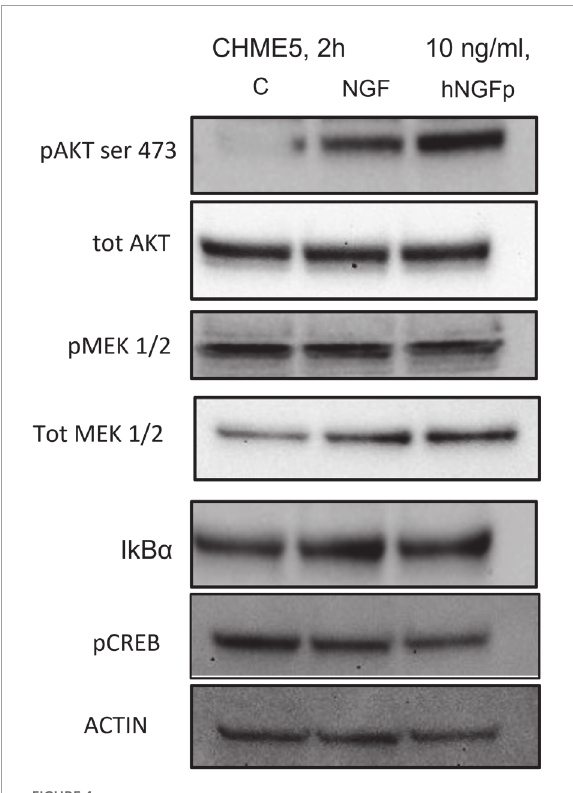
FIGURE4 Evaluation of tropomyosin receptor kinase A (TrkA) and p75NTR pathway in CHME-5 cells treated for 2 h with nerve growth factor (NGF) isoforms. Treatments: lanes 1, control; lane 2, 10 ng/ml NGF; lane 3, 10 ng/ml painless human Nerve Growth Factor (hNGFp). The following proteins were evaluated: pAKT (ser 473); tot AKT, p MEK1/2, tot MEK, IkB α , pCREB, and actin.